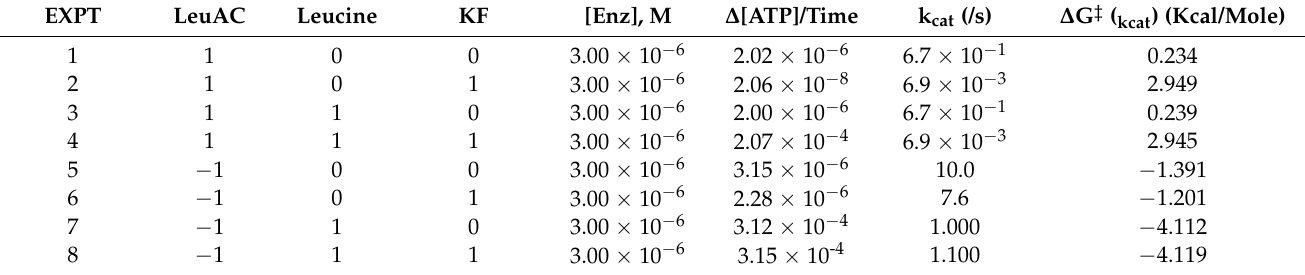
Table 2. Design matrix for dependences of PPi exchange. Independent variables are LeuAC (1) or LeuRS ( − 1), [Leucine] (1,0) potassium flouride (0,1), and enzyme concentration. Dependent variables are the rate of ATP formation and derived quantities: kcat = rate/[Enz], ∆ G ‡ (k cat ) = –RT ln(k cat ). The LeuAC2 construct was used as the MBP fusion in these